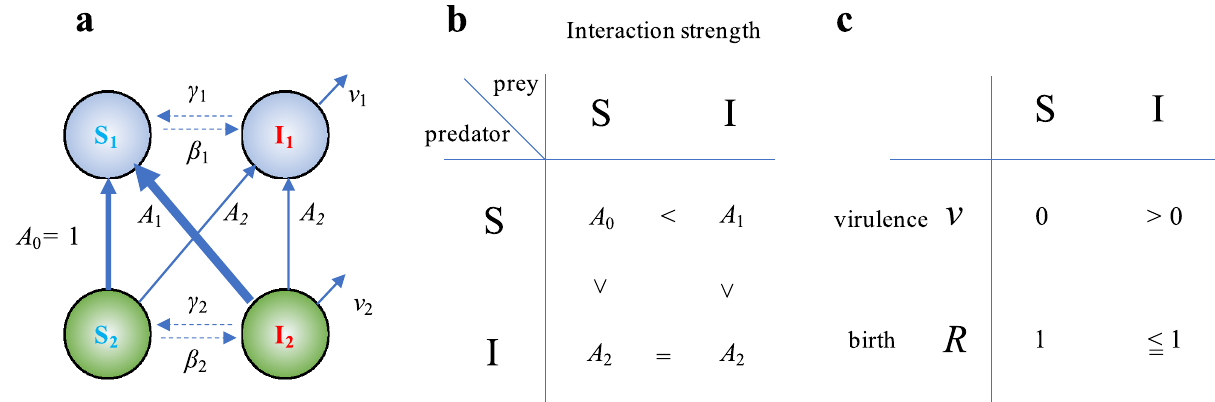
Figure 1. Schematic diagram of the simplest infected food web. ( a ) Model structure. S i and I i represent a susceptible and infected individual, respectively ( i = 1; predator, i = 2; prey). A 0 is the normalized interaction strength among susceptible predators and prey. A 1 and A 2 are the relative strength of interaction among predators and prey, indicated by each arrow to A 0 . Each species has a disease with transmission rate β i , virulence v i and recovery rate γ i . ( b ) Effects of the disease to interaction strengths between predator and prey. The strength of interactions are represented by the arrow thickness in ( a ). ( c ) Effects of disease to birth and death rates. In the main text, birth rate is same among susceptible and infected individuals, although the effect of birth reduction due to disease is shown in Supplemental